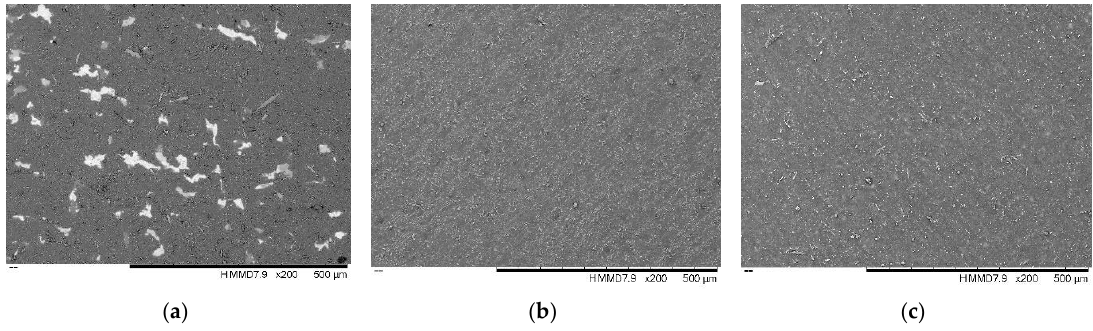
Figure 2. Surface of the investigated coatings (( a ) TiC, ( b ) ZrC, ( c ) TiNbC) determined by SEM method at magnification of ×200.